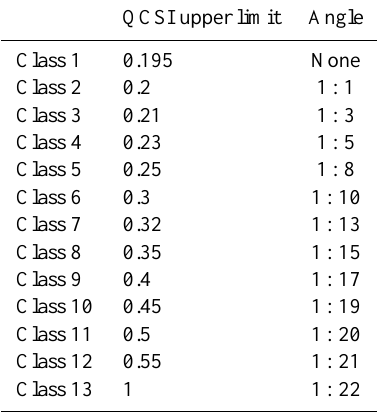
Table 3. Upper limits of the QCSI used to divide the best-case soil class in 13 subclasses and the assigned cross-sectional angle thresh-